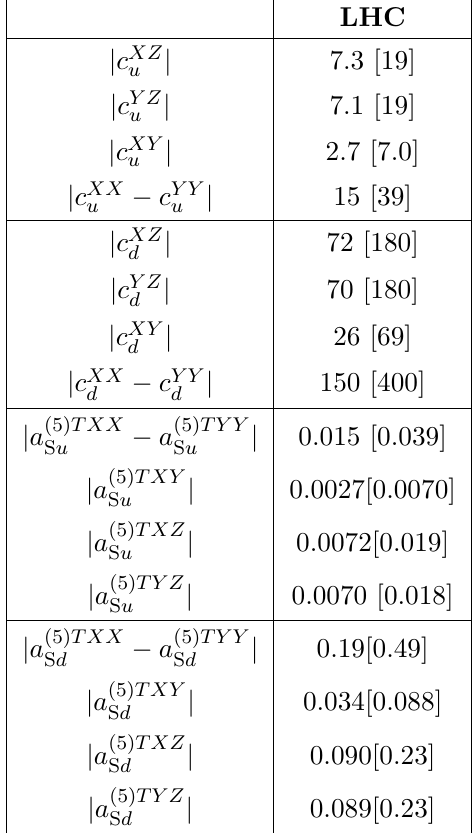
Table 3 . Expected best sensitivities on individual coe(cid:14)cients c JK the DY process at the LHC. Values are in units of 10 (cid:0) 5 and 10 (cid:0) 6 GeV (cid:0) 1 , respectively. Results with brackets are associated with uncorrelated systematic uncertainties between binned data, while results without brackets correspond to the assumption of 100% correlation between systematic uncertainties.